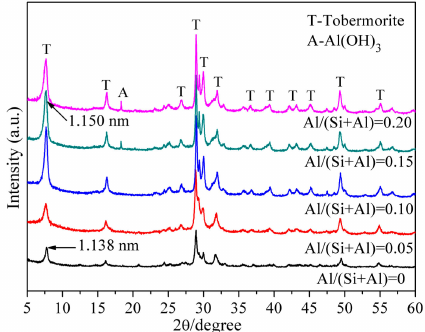
Figure 1. XRD patterns of hydrothermal synthesized Al-tobermorite with di ff erent Al / (Al + Si) molar